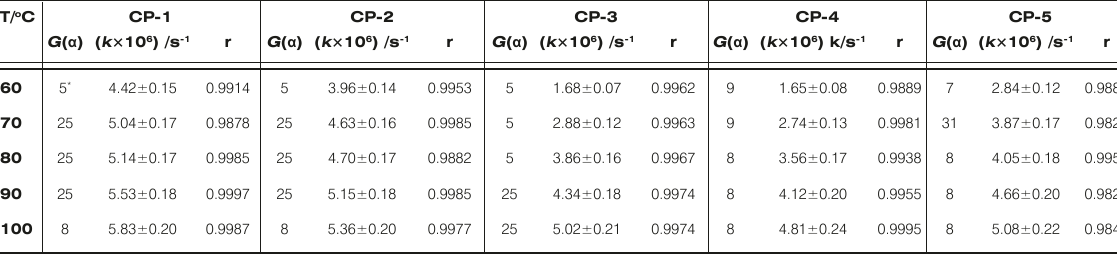
* Refer to Supplementary data for more details about the mechanism functions.